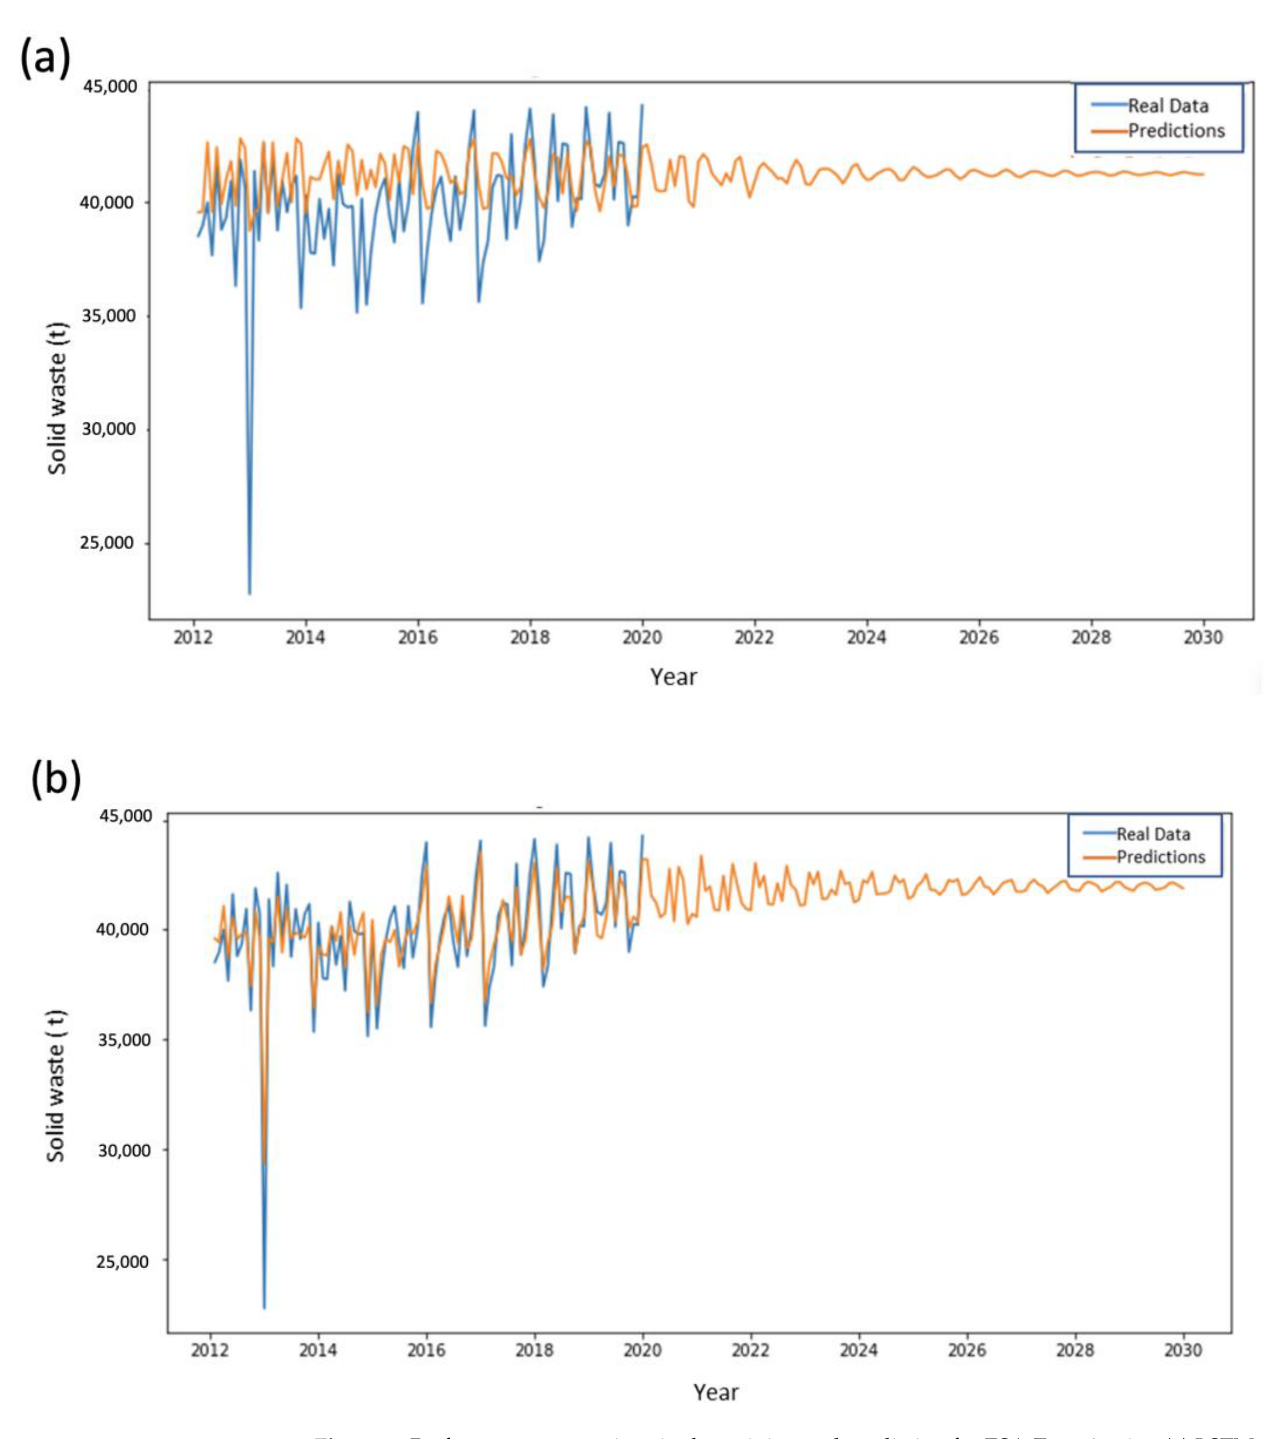
Figure 5. Performance comparison in the training and prediction for ESA Zone 1 using ( a ) LSTM and ( b ) SVMs.